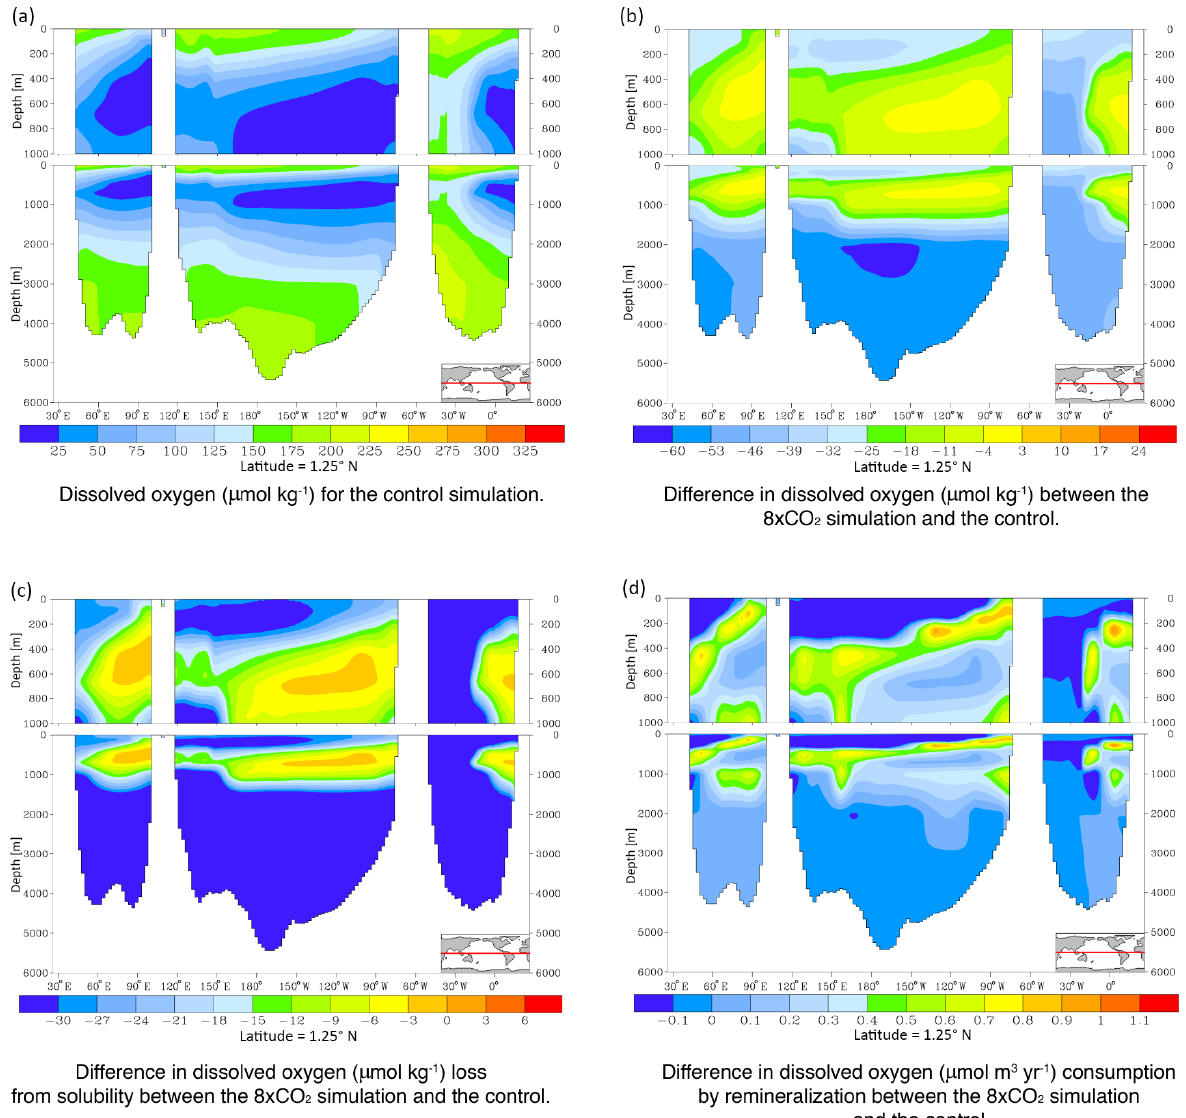
Figure 10. Mechanisms for oxygen loss in the OMZs at 8 × CO 2 . (a) Reference simulation. (b) The difference in DO concentrations between 8 × CO 2 and the reference simulation. (c) The difference in DO lost due to changes in solubility between 8 × CO 2 and the reference simulation. (d) The increase in oxygen consumption due to remineralization of organic carbon between the 8 × CO 2 and reference